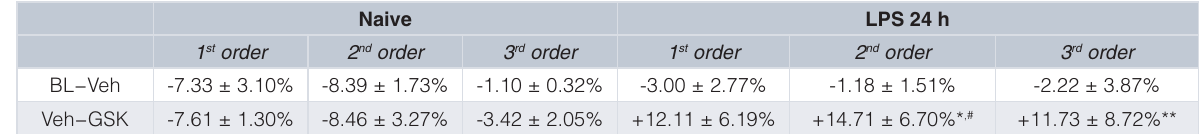
Table 4. Change in mesenteric blood flow following topical TRPV4 activation in naïve and septic mice. Baselines (BL), and responses to aerosolised vehicle (Veh; 10% DMSO in pre-warmed saline) and GSK1016790A (GSK; 1 µM) were recorded over sequential 5-min periods. Data are presented as mean percentage change in area under the curve over 5-min recording period. *p<0.05, **p<0.01, relative to vehicle response in the same mouse, paired 2-tailed Student’s T-test; # p<0.05 relative to corresponding